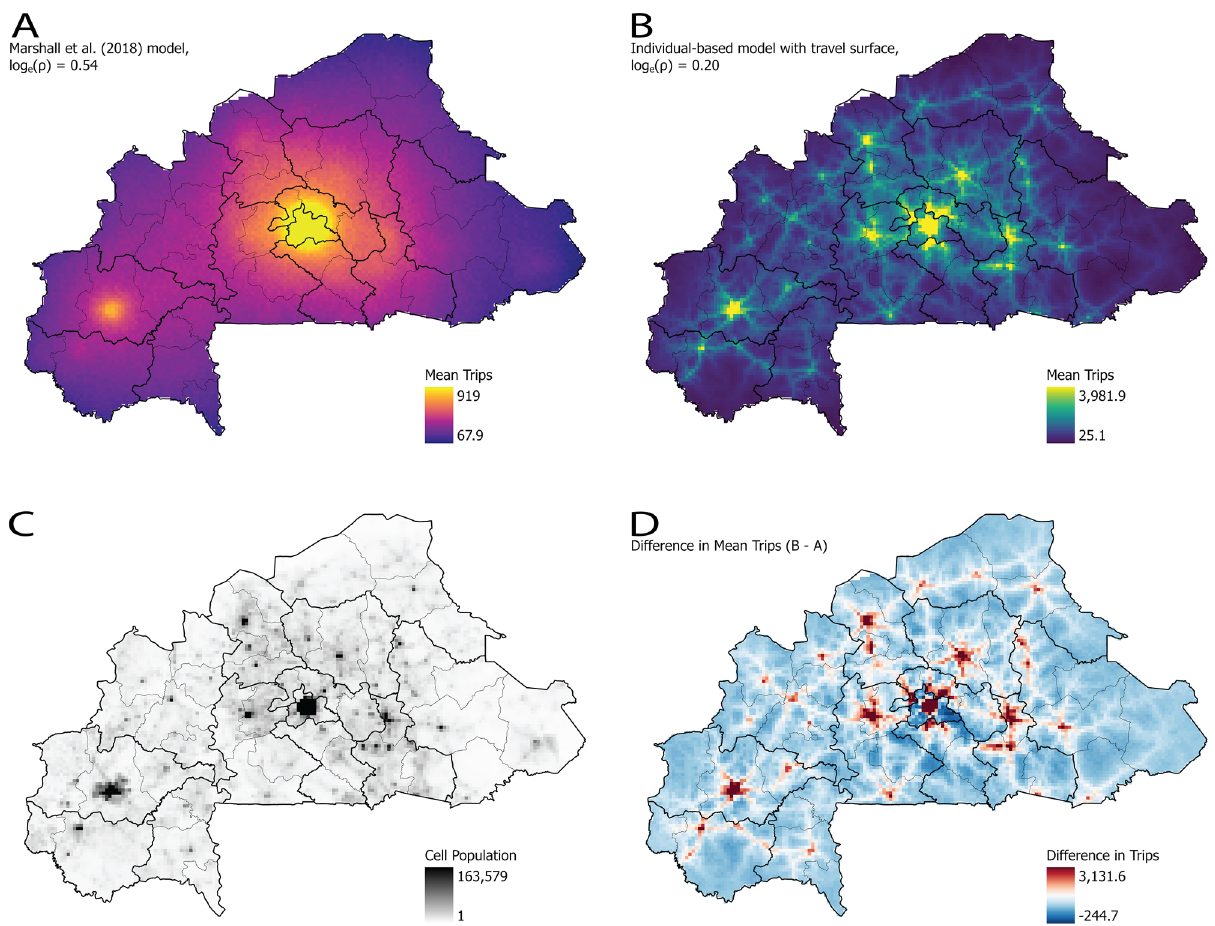
Figure 3. Comparison of the gravity model with kernel function parameterized by Marshall et al. 8 versus the mathematical model with travel surface and parameterization described, as implemented in the individual- based model. ( a ) The mean number of trips for ten replicates to the destination cell in a single month using the parametrization prepared by Marshall et al. 8 ( b ) The mean number of trips for ten replicates to the destination cell in a single month using the mathematical model with travel surface and parametrization described in this manuscript. ( c ) The population distribution of Burkina Faso from WorldPop 18 aggregated into the same 5 km-by-5 km cells used for movement. ( d ) The raster algebra difference between the mean number of trips to the destination cell from ( a , b ); note that the Marshall et al. 8 model tends to project higher movement to rural areas (negative values in blue tones) compared to ( b ) which is shifted towards the areas of higher population using the method described here (positive values in red tones). Furthermore, the movement is less diffused compared to ( a ). However, the lack of diffusion results in movement being better aligned with the concentrations of population and transportation networks compared to ( a ) despite the total number of trips being similar. Maps prepared by the authors using ArcGIS Pro (version 3.0.3, https:// www. esri. com/ en- us/ arcgis) using administrative boundaries from the World Bank Group 11 and data from the simulation parameterization may offer a useful starting point for model developers, additional algorithm development, parameterization, and calibration steps are necessary to ensure that the model is appropriate for expected move-